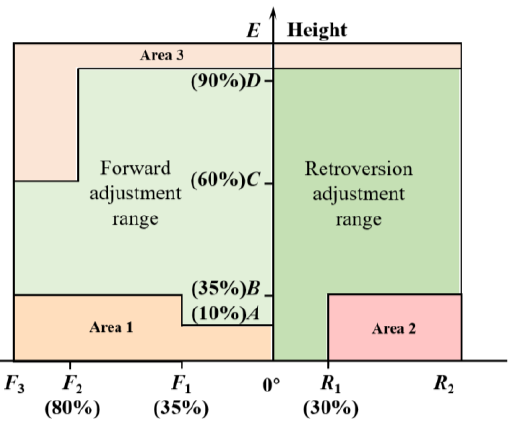
Figure 6. Longitudinal leveling posture range: E , F 3 and R 2 represent the maximum lifting height, maximum forward and maximum retroversion adjustment angles of the chassis, respectively; A , B , C and D represent 10%, 35%, 60% and 90% maximum lifting vehicle height, respectively; F 1 and F 2 represent 35% and 80% maximum forward angle, respectively; R 1 represents 30% maximum for- ward angle.